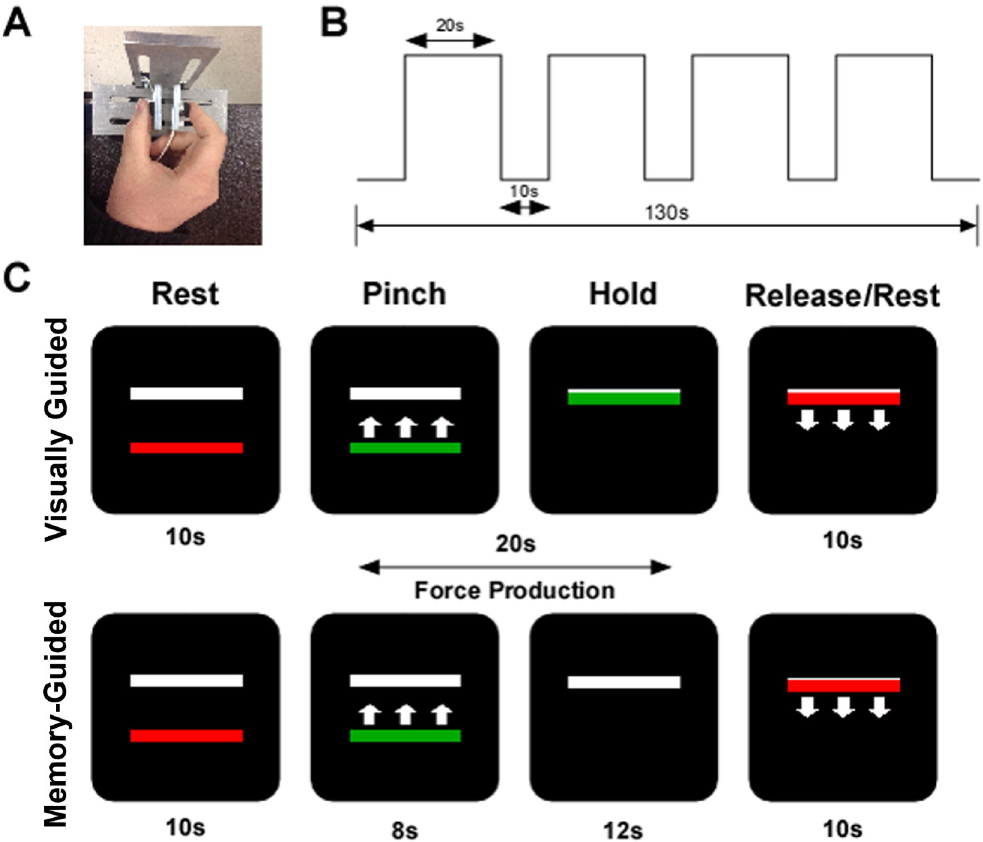
Fig 2. Visually guided and memory-guided force paradigm. A) The precision grip apparatus with load cells under the thumb and index finger; B) the experimental procedure was 130 s in length. Each block of 20 s of force was separated by 10 s of rest; C) the visual display contained two horizontal bars presented against a black background. The target bar (white) was stationary, and the red/green force bar provided real-time visual feedback. In the visually guided task, visual feedback was available for the duration of the trial. In the memory-guided task, the force bar disappeared for the last 12 s of the